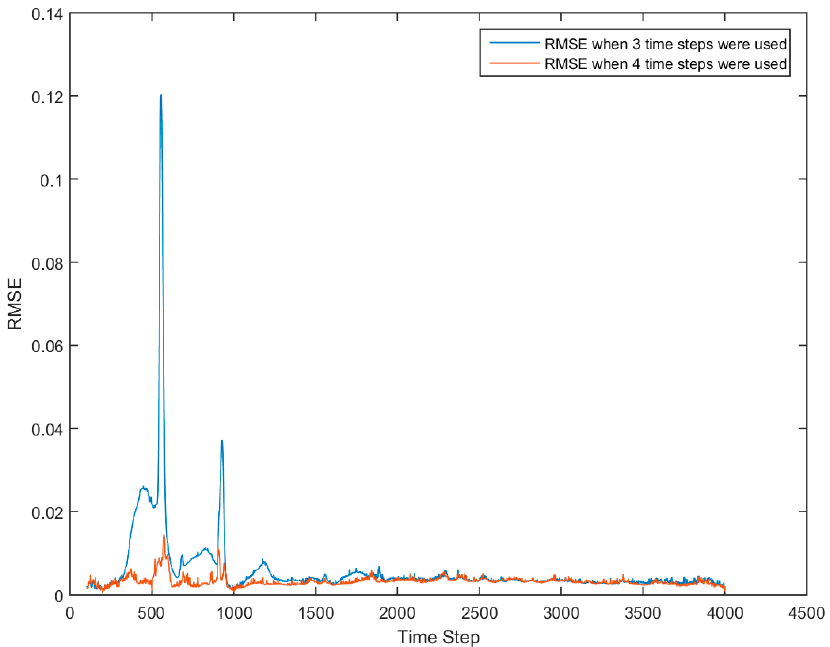
Figure 24. CFD and smart proxy results for gas volume fraction at K = 1 cross-sectional plane.